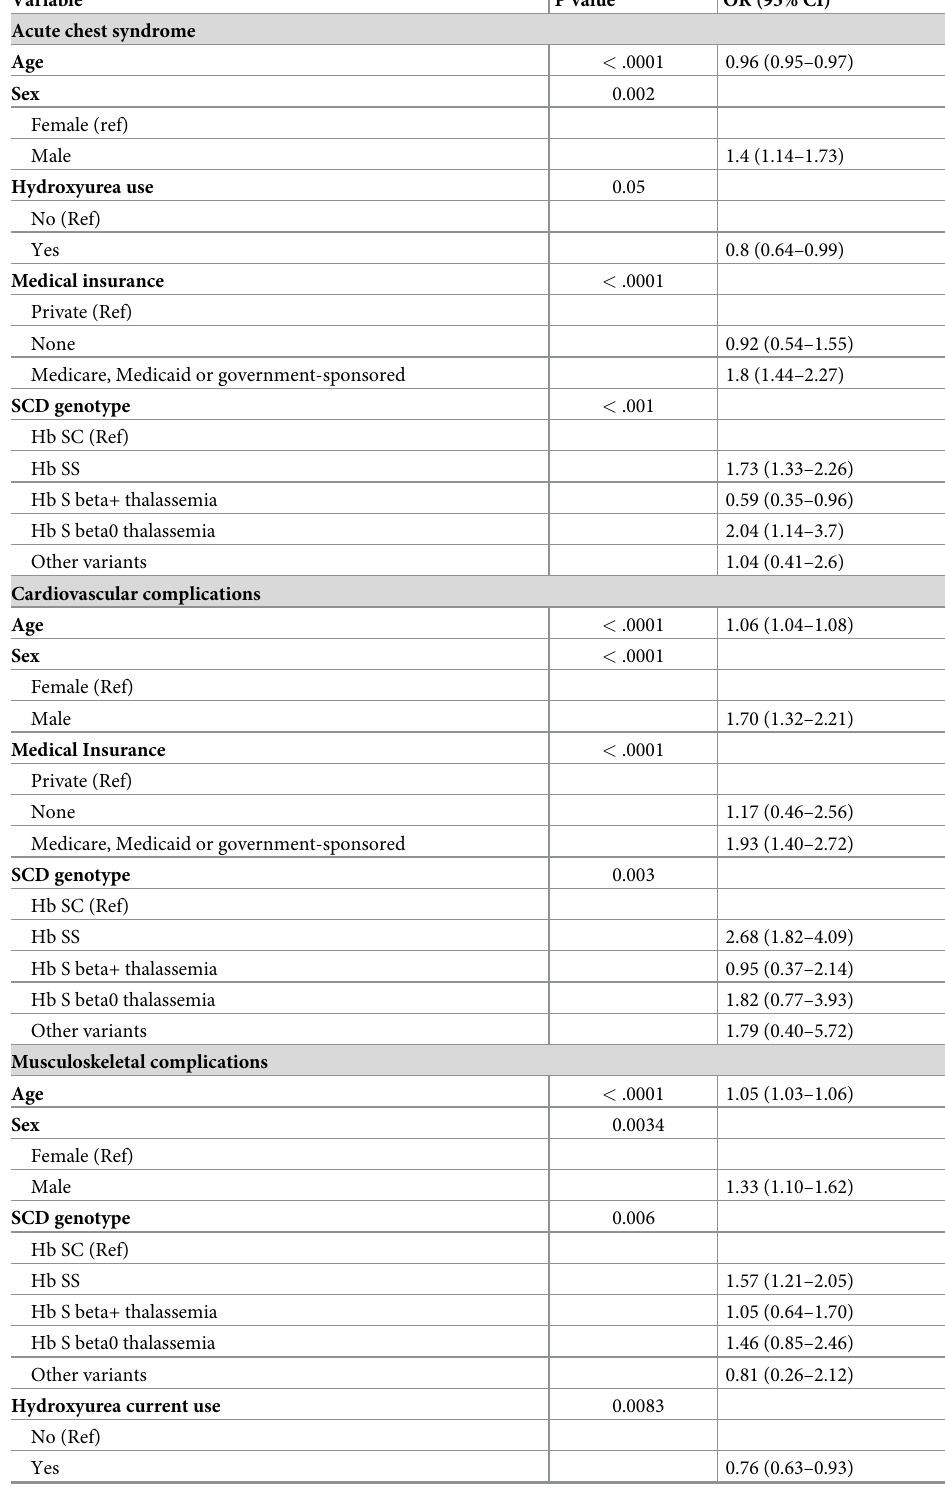
Table 3. Association between participant demographics and sickle cell disease